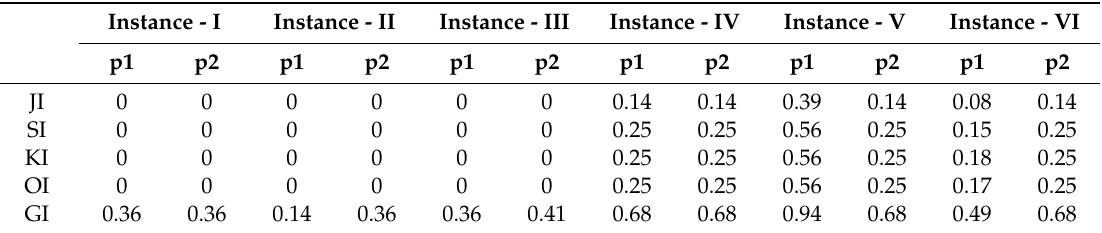
Table 1. Similarity scores of test data over six instances in terms of similarity